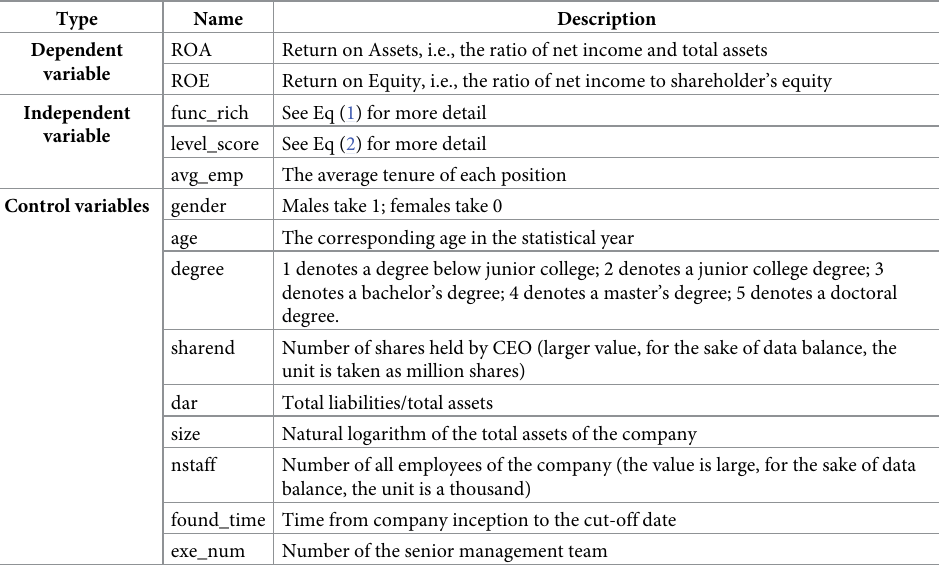
shown in Eq (1). Where p is the frequency of the i th category of tenure position in the career, i and the value range of i is [7, 50]. Positions in the resume were divided into nine categories: production, R&D, design, human resources, management, marketing, finance, legal, and oth- ers. For example, if a CEO held 13 positions in their career, of which three were in the finance category, the frequency of positions in the finance category is 3/13. The higher the final calcu- lated score, the more experience the CEO has in each category of positions and the broader the CEO’s breadth.